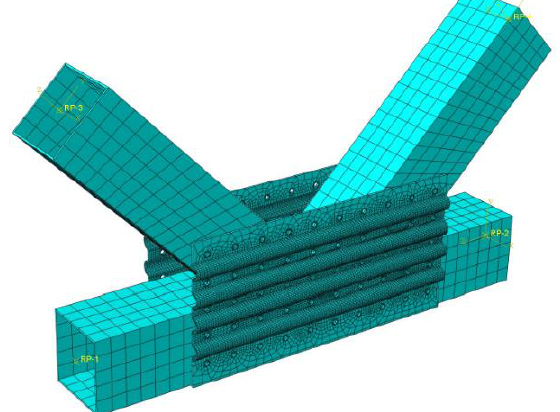
Figure 20. Illustration of interactions between the connector and the SHS member.